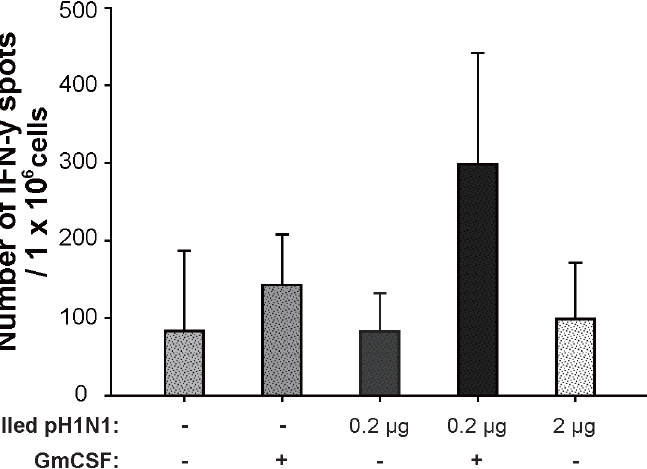
Fig 5. Analysis of IFN- γ production in mice immunized with killed virus vaccine together with AcHERV-GmCSF. The number of IFN- γ spots from pH1N1-specific T cells in splenocytes (3/16) 2 weeks post immunization were analyzed using an ELISPOT assay. Statistical analysis showed that data were significant with p < 0.05 (one way